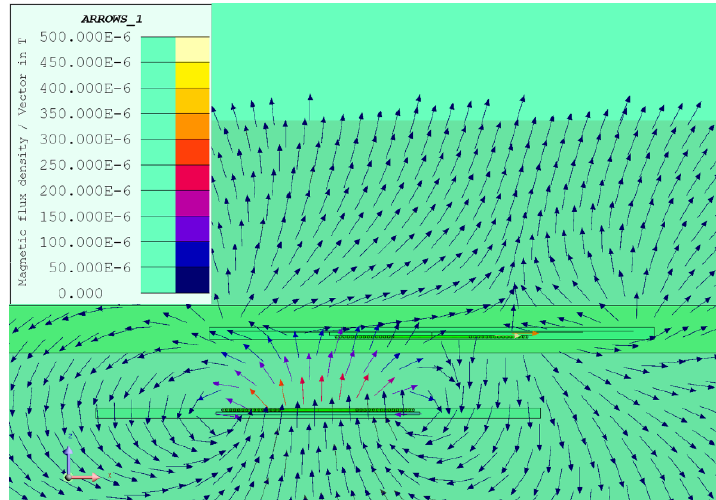
Figure 4. Magnetic flux density map of the device with M = 0.